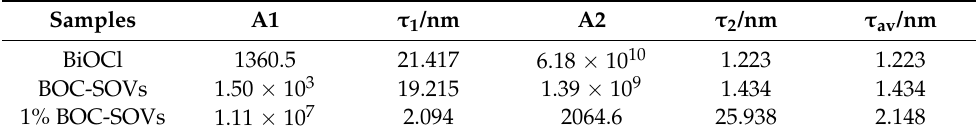
Table 2. Charge life according to time-resolved transient PL decay curves.